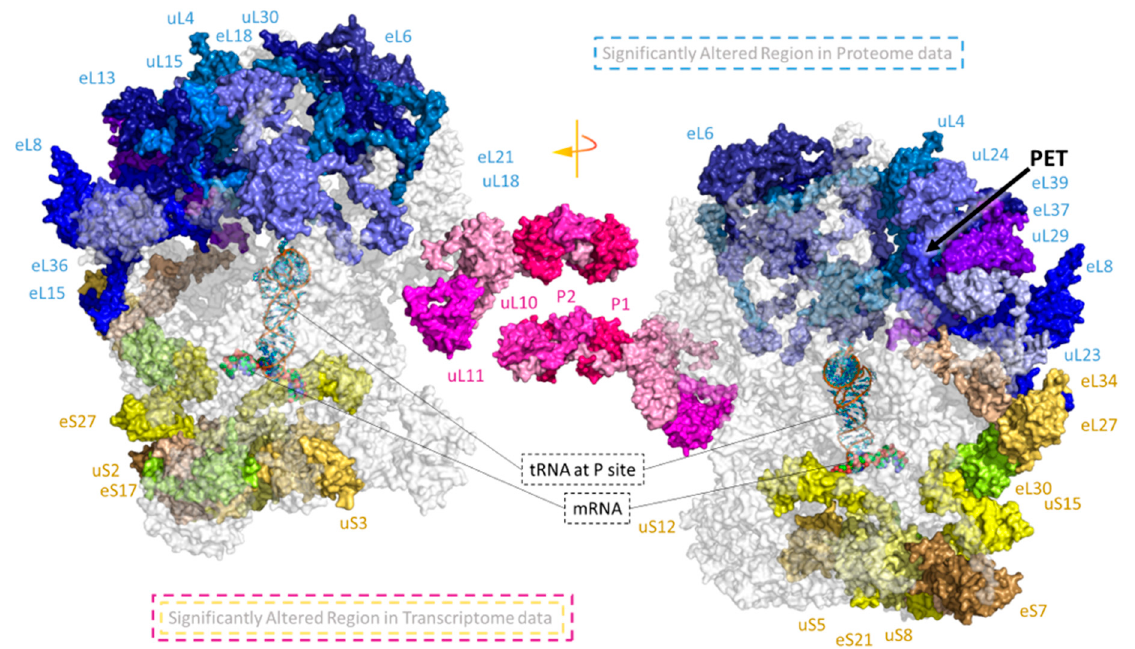
Figure 6. Significantly altered ribosomal regions during cold acclimation in Arabidopsis thaliana roots measured in three independent genotypes and four biological replicates in total. The figure is a visualization of the random walk sampling results and tested regions of interest detailed in the GitHub repository COSNet i (https://github.com/MSeidelFed/COSNet_i, accessed on 30 April 2021). Sampled regions with a significantly increased proportion of RP changes as compared to the entire ribosome are depicted based on testing of the transcriptomic (shades of magenta and yellow) and proteomic (shades of blue) datasets. The binary input for the tests has been compiled in Table S6. Additionally, several regions had significant results at a threshold p value < 0.05 before the multiple testing correction and are reported in Figure S6. Note that at the transcript level one of the significantly altered regions co-localizes with the P site where tRNA binds as well as where the decoding of mRNA occurs. At the proteomic level, the significances co-localized with the polypeptide exit tunnel (PET) depicted with a solid arrow. Both ribosomal images represent a 180° rotated mirror image of each other.